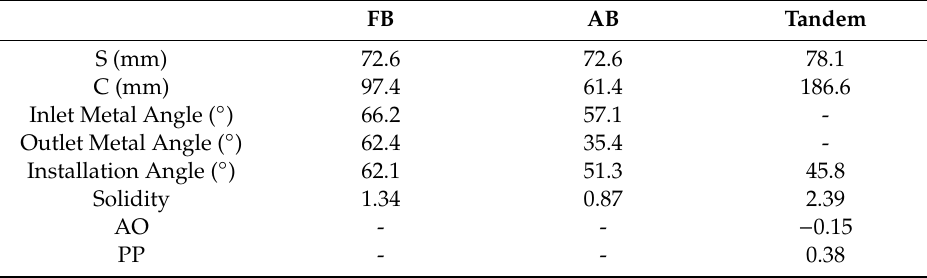
Table 3. Tandem blade geometric parameters.